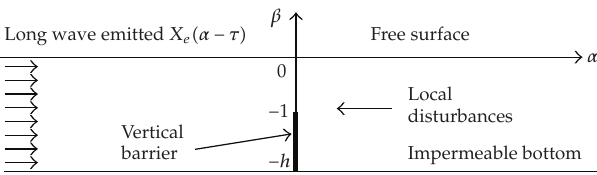
Figure 1: Local disturbances at vicinity of the